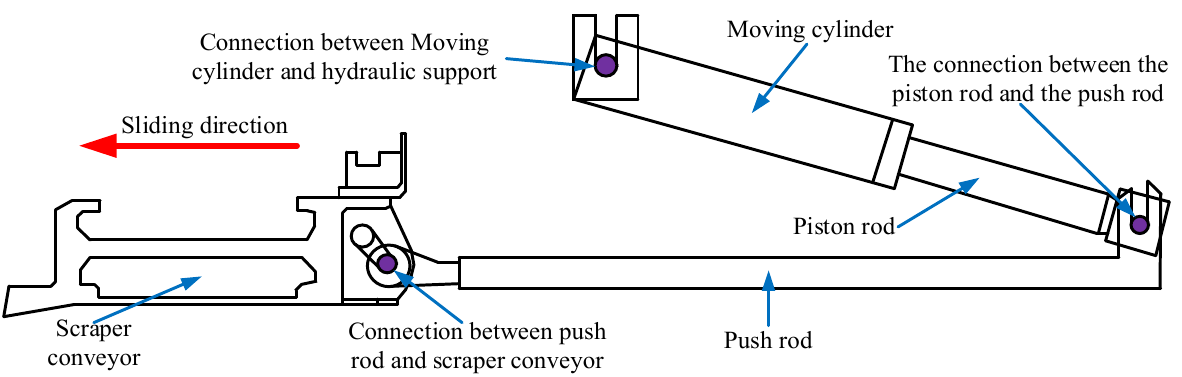
Figure 16. Schematic diagram of cylinder moving of hydraulic support.